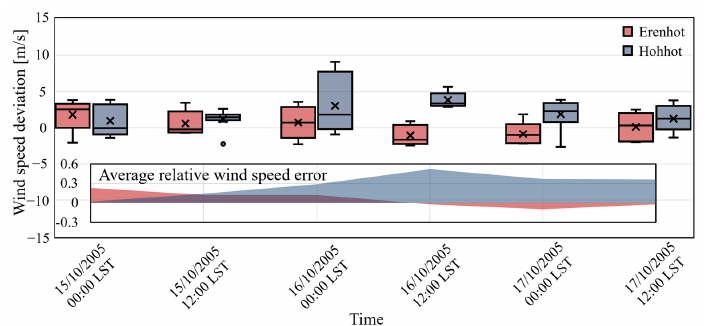
Figure 6. Statistical deviations of mean wind speed field obtained from WRF forecasts in the “Shen Zhou 6” case. Table 3 further shows the specific statistical biases of the mean wind speed for a more intuitive look. The results show that the average deviation is positive, meaning that the WRF forecasts are generally larger than the observations. Consistent with that shown in Figure 5, deviations are more minor in Erenhot than in Hohhot. In Erenhot, the absolute